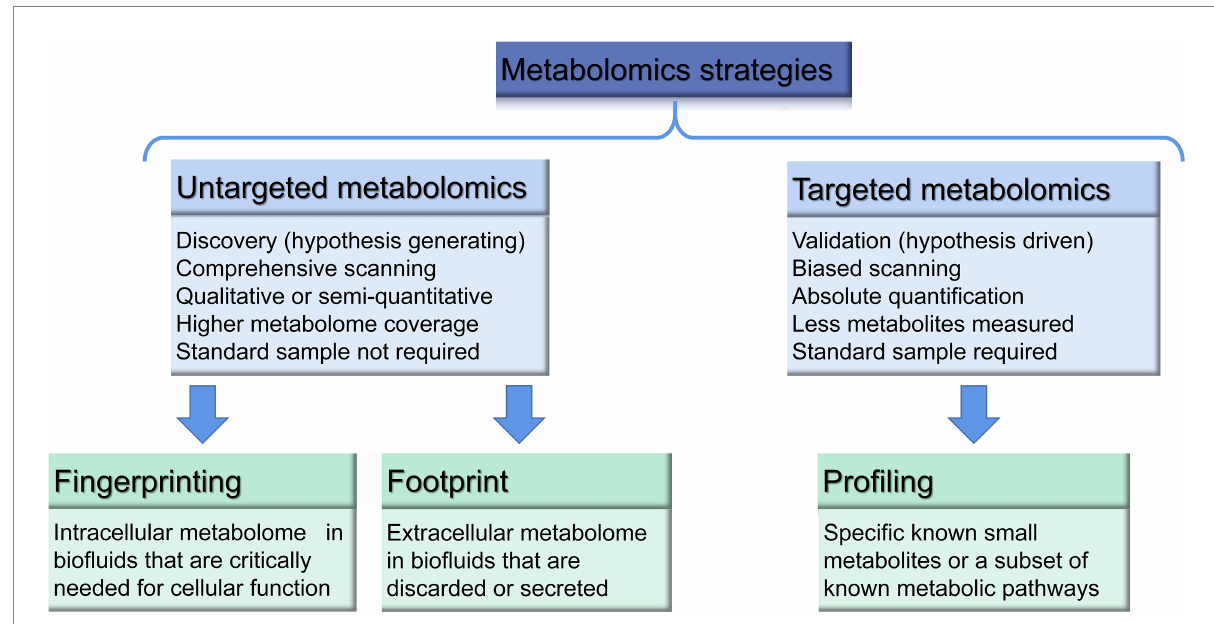
FIGURE 1 Main strategies of metabolomics modified according to literatures (Villas-Bôas et al., 2005; Klassen et al., 2017; Aszyk et al., 2018; Nalbantoglu,